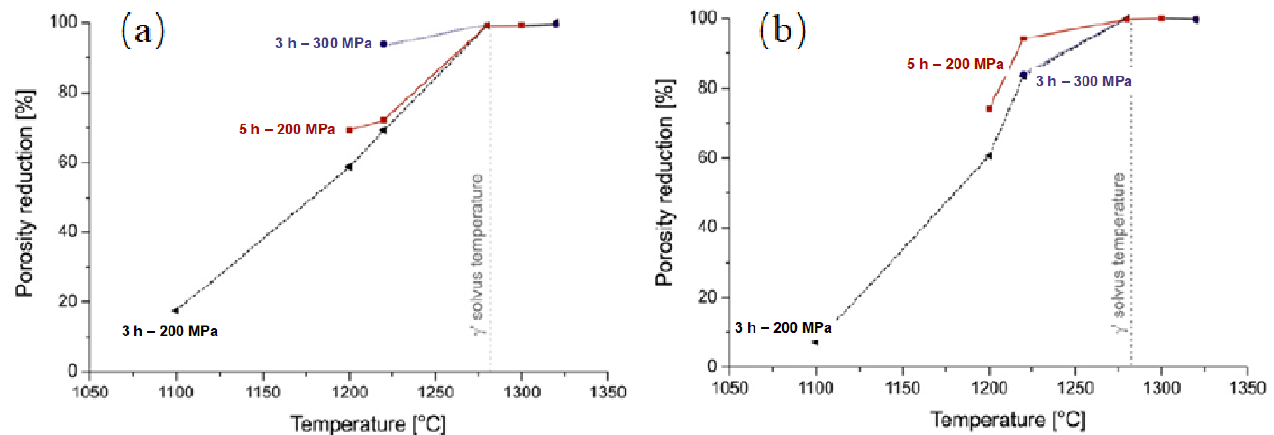
Figure 5. Effect of the temperature on the annihilation of micropores of ( a ) as-cast and ( b ) as-SHTed SX superalloy ERBO/1 [24] .